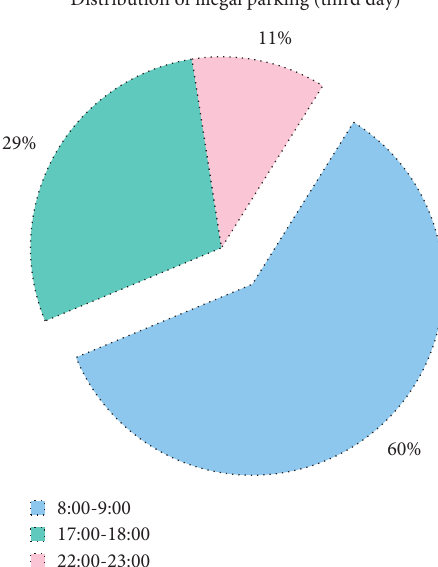
Figure 6: Distribution of illegal parking in different periods on the third